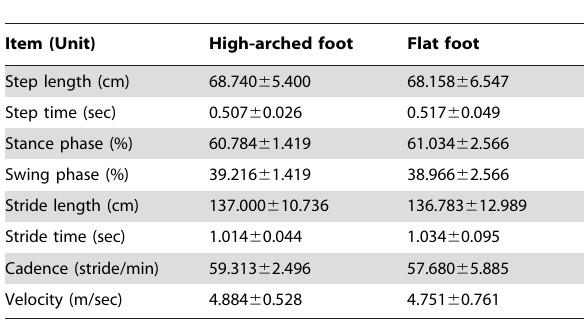
Table 2. Basic kinematic parameters of gait.